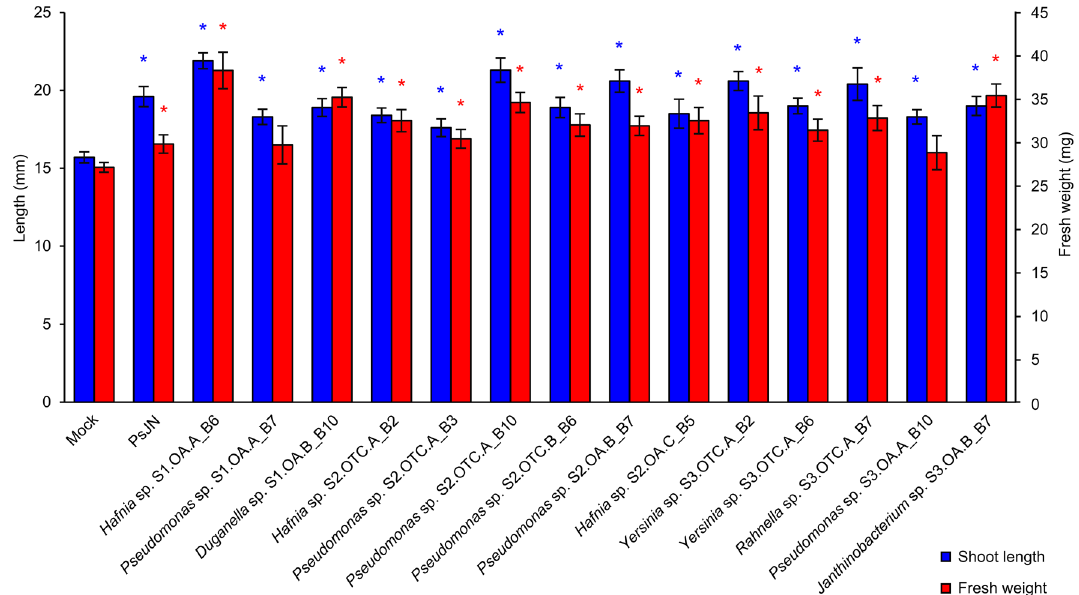
Figure 4. Growth promotion of tomato seedlings by psychrotolerant bacterial isolates of Colobanthus quitensis . The shoot length (mm, blue bars) and fresh weight (mg/plant; red bars) were analyzed for mock-inoculated plants (Mock) and plants inoculated with psychrotolerant bacterial isolates obtained from C. quitensis leaves. Assessments were carried out 15 days after seed inoculation and plant incubation at 15 ± 1 °C.